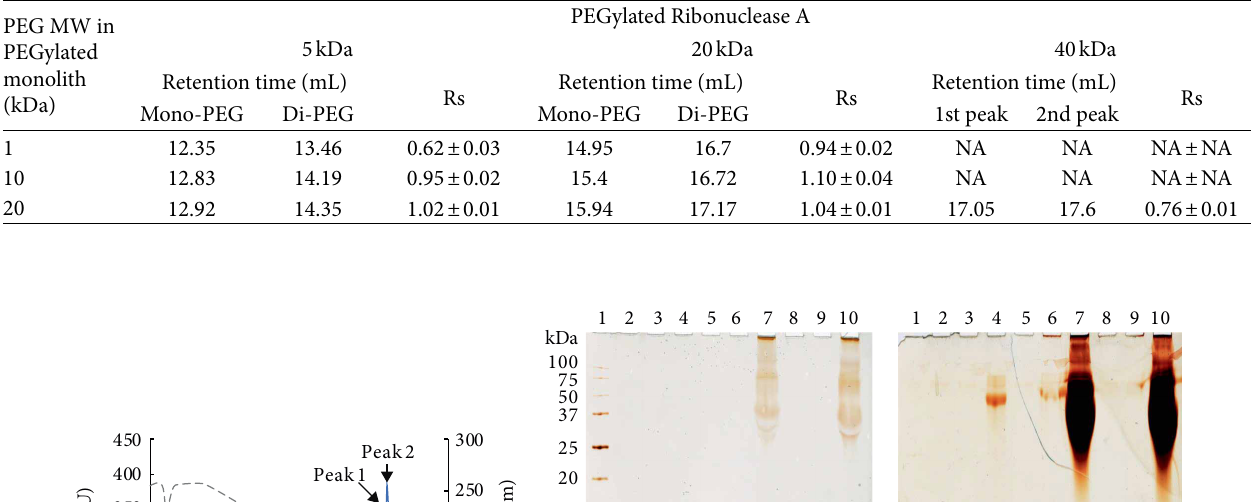
Table 2: Retention time and resolution factor (Rs) of PEGylated Ribonuclease A using PEGylated monoliths.